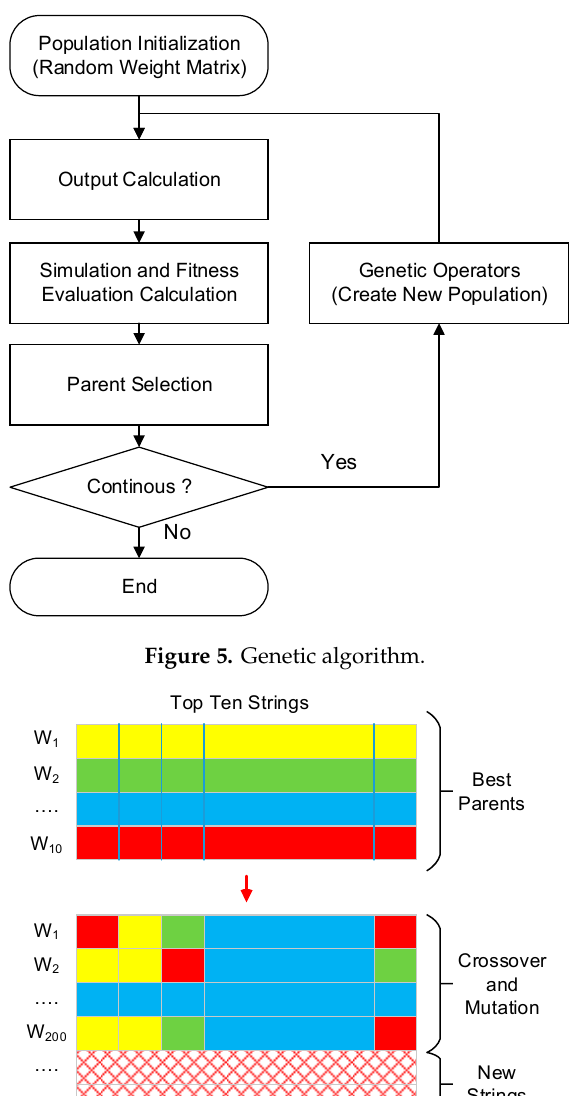
Figure 6. Generating a new population.